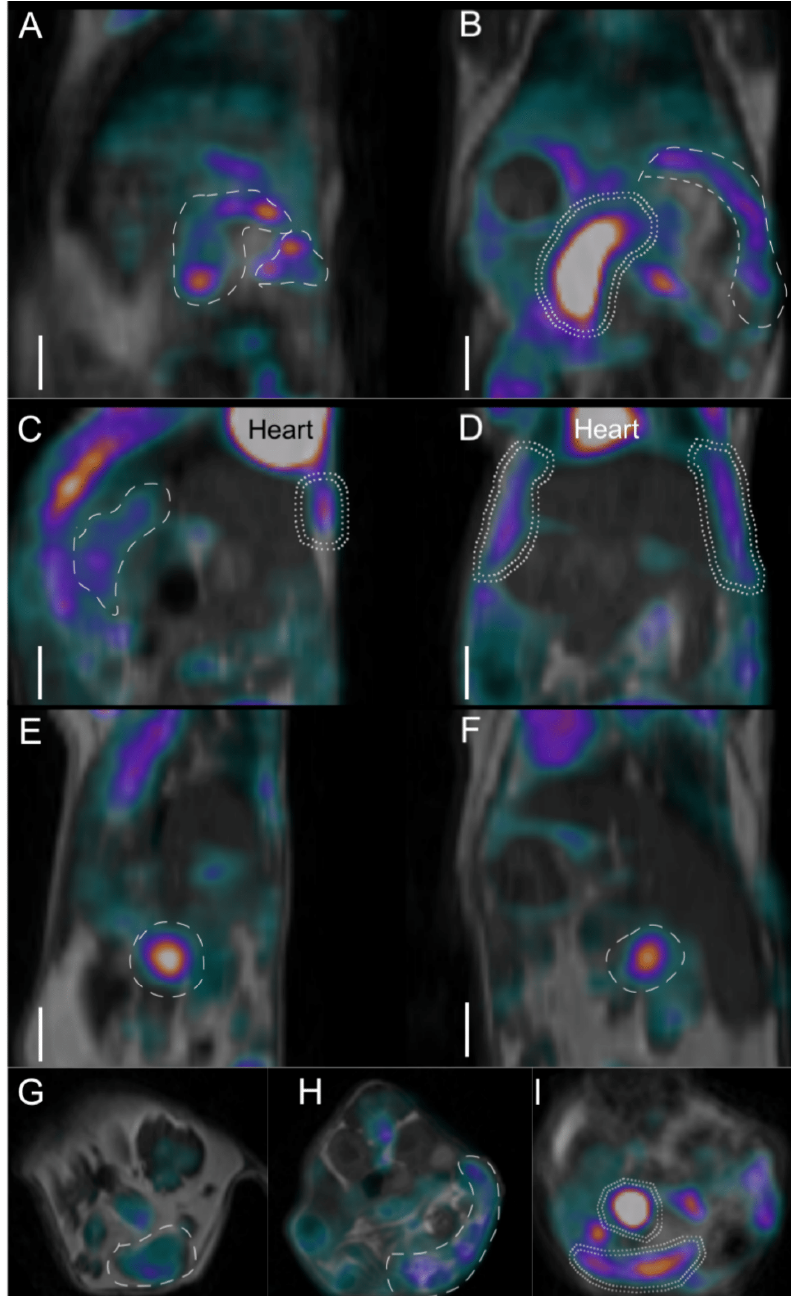
Figure 7. Positron emission tomograph (PET) / magnetic resonance imaging (MRI) imaging of WT ( A , B , I ) and IL-6 KO ( C , D , E , F , G , H ) mouse abdominal regions in three section planes. ( A ) Sagittal planes of WT mouse; ( B ) horizontal section of WT mouse; ( C , E ) sagittal planes of IL-6 KO mice; ( D , F ) horizontal planes of IL-6 KO mice; ( G , H ) cross-sections of IL-6 KO mice; ( I ) cross-section of WT mouse abdomen. High [18F]-fluoro-deoxy-d-glucose (FDG) activity uptake regions (over 0.2 standardized uptake values (SUV values) are circumscribed with dashed lines. Double-dashed line shows very high (over 0.4 SUV value) FDG uptake regions. Color scales are grayscale for the background anatomic MRI images, while the PET component shows low uptake in black (no uptake) to blue (low uptake), moderate in purple to red and higher FDG uptake in red through yellow to white (highest uptake). Heart is annotated in panels C and D for reference. White scale bars in each panel equal 500 microns.